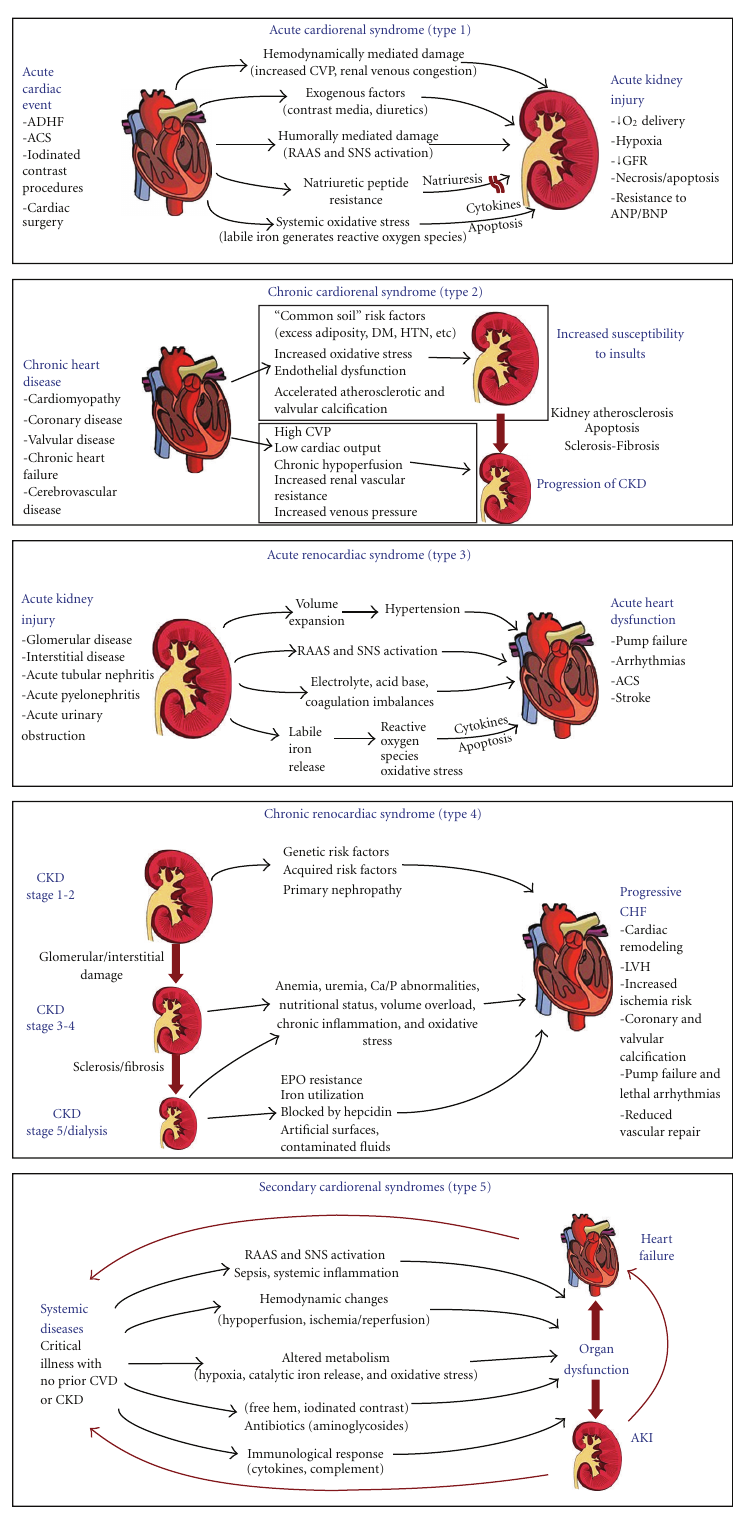
Figure 1: Pathophysiology and definitions of the five subtypes of cardiorenal